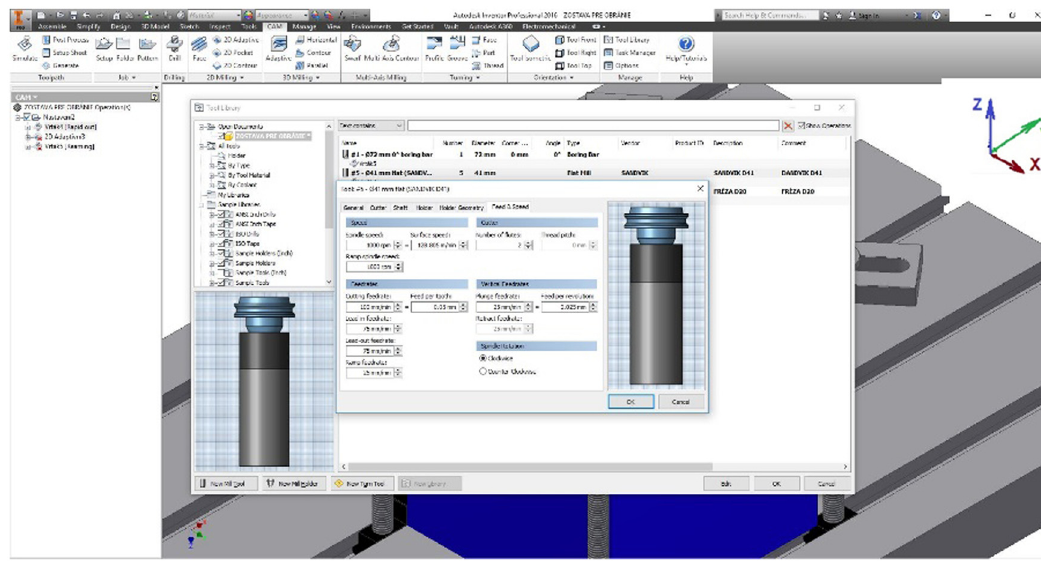
Figure 5: Setting of cutting parameters.